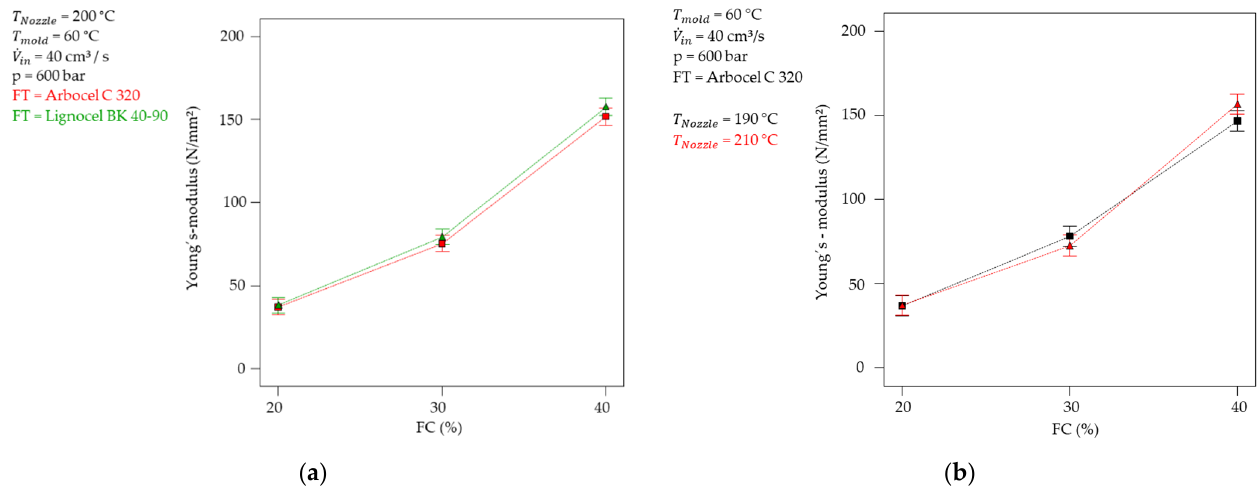
Figure 5. ( a ) Young’s modulus of wood ‐ filled TPU as a function of fiber content and fiber type. ( b ) Young´s modulus of wood ‐ filled TPU in dependence of temperature control.